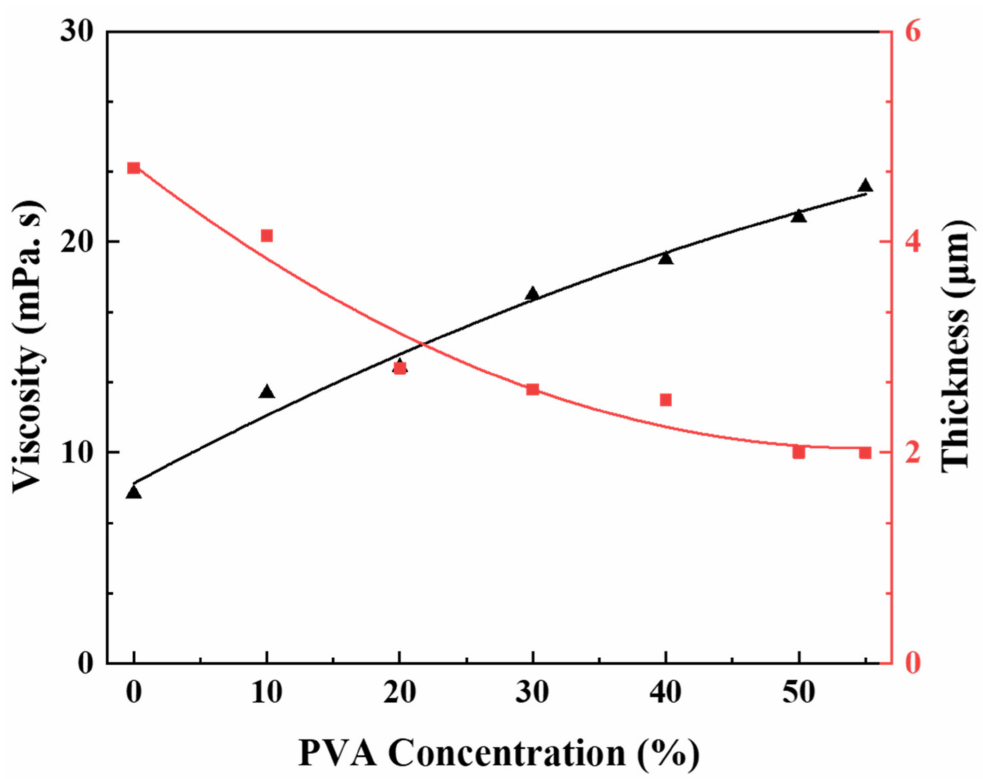
Figure 3. Schematic presentation of solution viscosity and thickness of γ -Al 2 O 3 membrane A as a function of the PVA concentration in boehmite